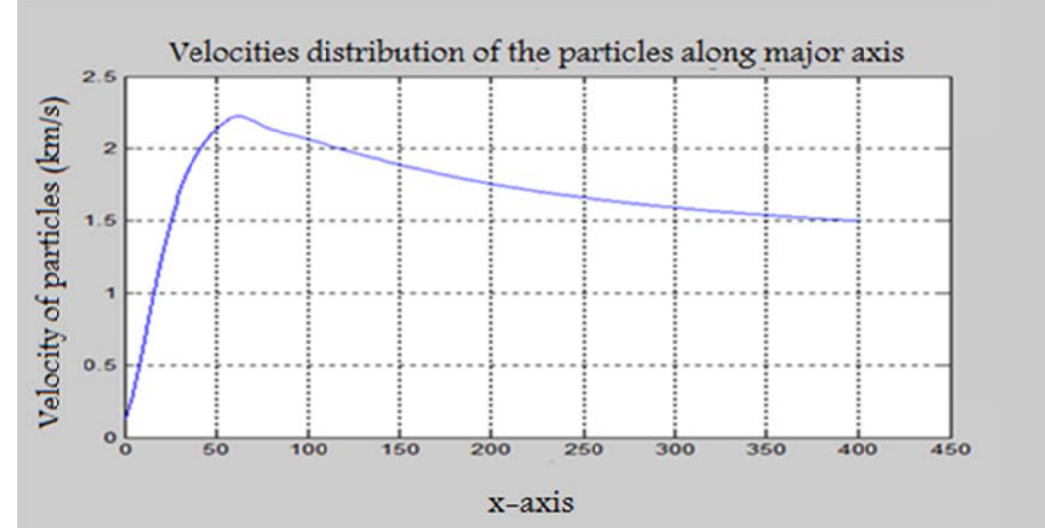
f particles ve locity is